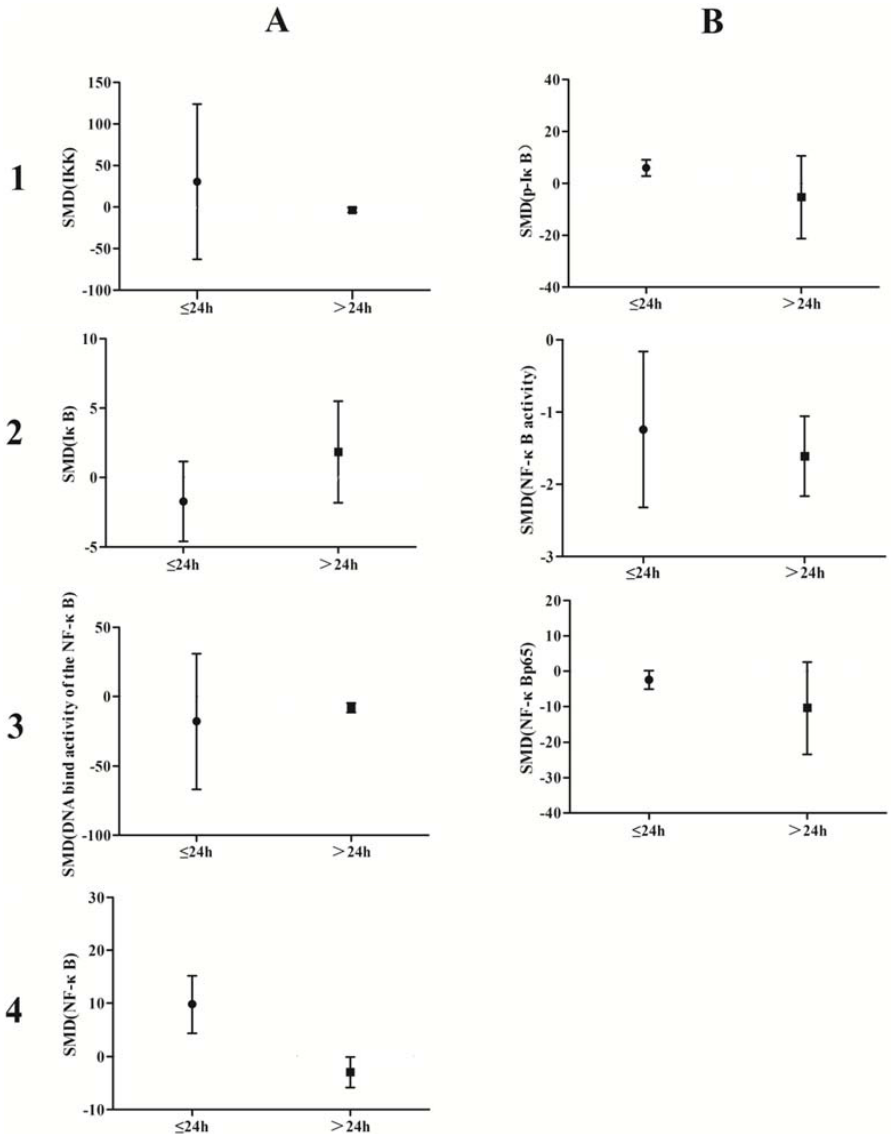
Figure 10. Subgroup analyses to determine the effects of arsenic on NF ‐κ B. Based on exposure